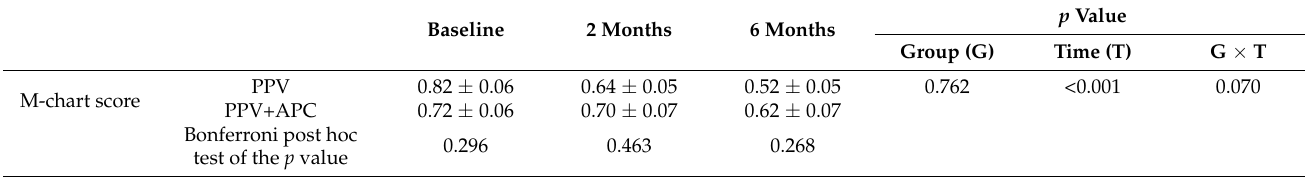
Table 5. Comparison of metamorphopsia assessed with M-chart score between the two